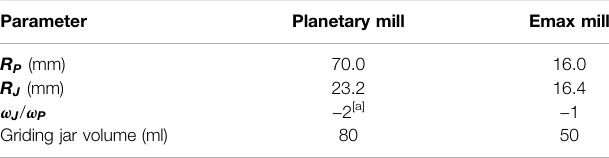
TABLE 1 | Characteristic parameters of the planetary ball mill ( “ Pulverissete 7 Premium Line ” ) and the high-energy Emax ball mill (Retsch GmbH).